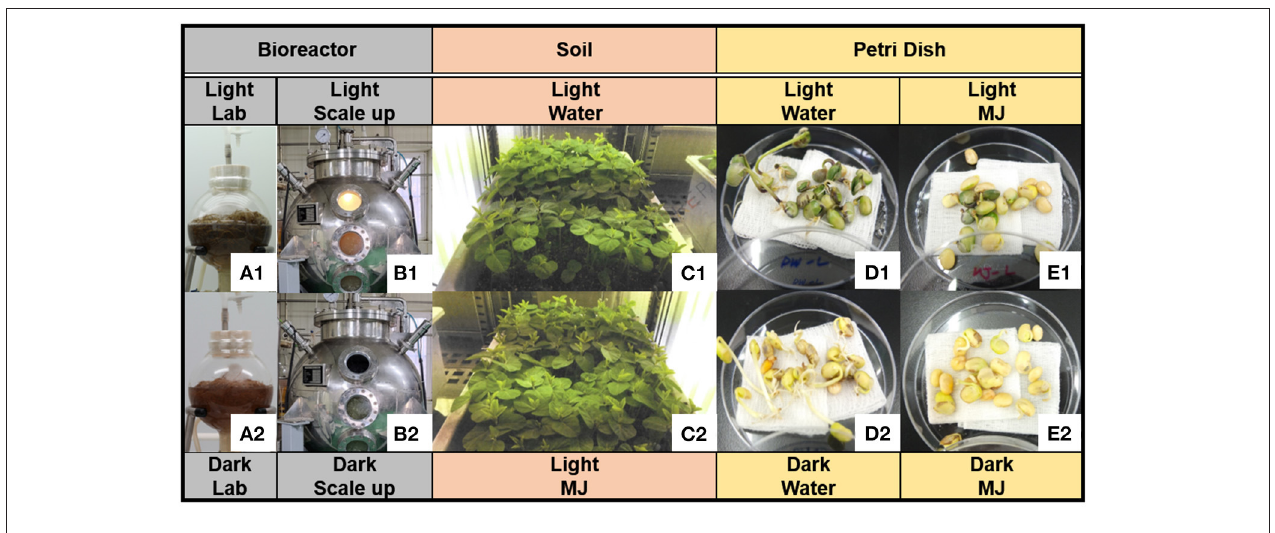
FIGURE 2 | Three cultivation methods of soybean. (A) Lab-scale culture of soybean adventitious root (AR) [ (A1) light condition; (A2) dark condition], (B) pilot-scale culture of soybean AR, (C) soybean plants cultured in artificial soil (AS) with water (C1) and methyl jasmonate (MJ) (C2) under light–dark cycle conditions, (D) seedlings in water under (D1) light and (D2) dark conditions, and (E) seedlings in MJ under (E1) light and (E2) dark